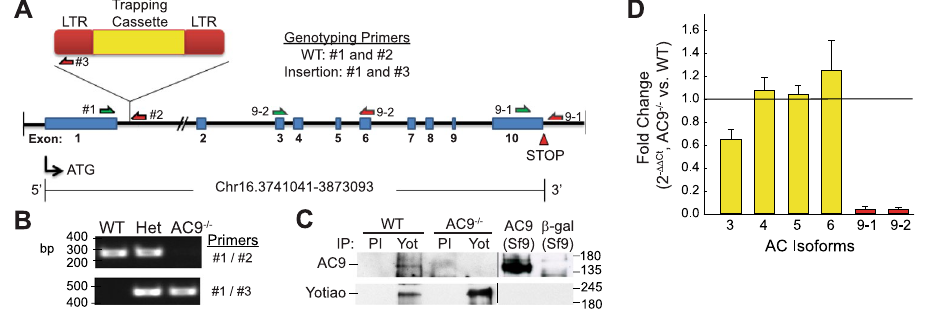
Figure 1. Design and verification of the AC9 − / − mouse model. ( A ) Schematic of AC9 gene-trap strategy and genotyping primers. Intron distances are not drawn to scale. ( B ) PCR analysis of genotyping: lanes 1, 2, and 3 represent wild-type (WT), AC9 + / − (Het) and AC9 − / − , respectively. ( C ) AC9 protein levels were detected by immunoprecipitation of pre-immune (PI) or Yotiao complexes from WT and AC9 KO heart extracts followed by western blotting (WB) with anti-AC9 antibody. AC9 protein is not detectable in total heart extracts by WB (n = 5). ( D ) Real time PCR of cardiac AC isoforms in AC9 − / − heart, normalized to WT expression levels (n = 3; mice 1 month of age). Loss of AC9 mRNA was confirmed with primer sets 9-1 and 9-2. Full-length WBs are presented in Supplementary Fig.